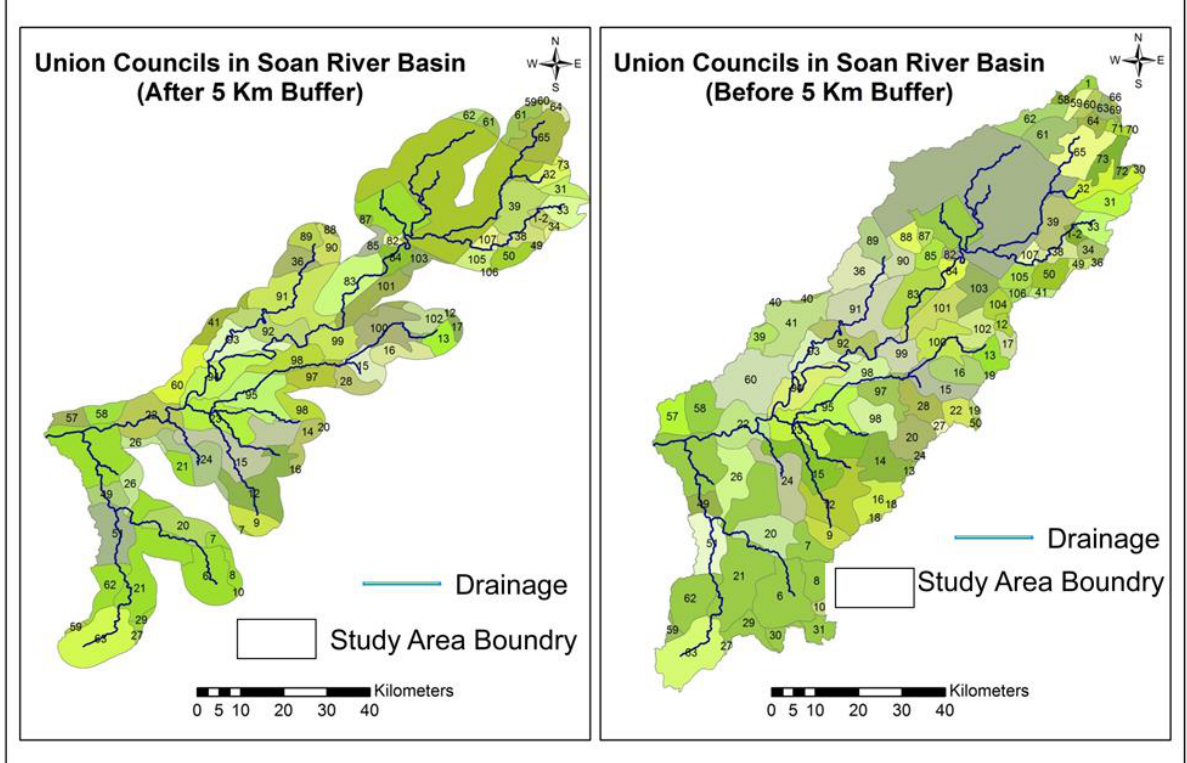
Figure 3. Union councils with and without buffer zone.